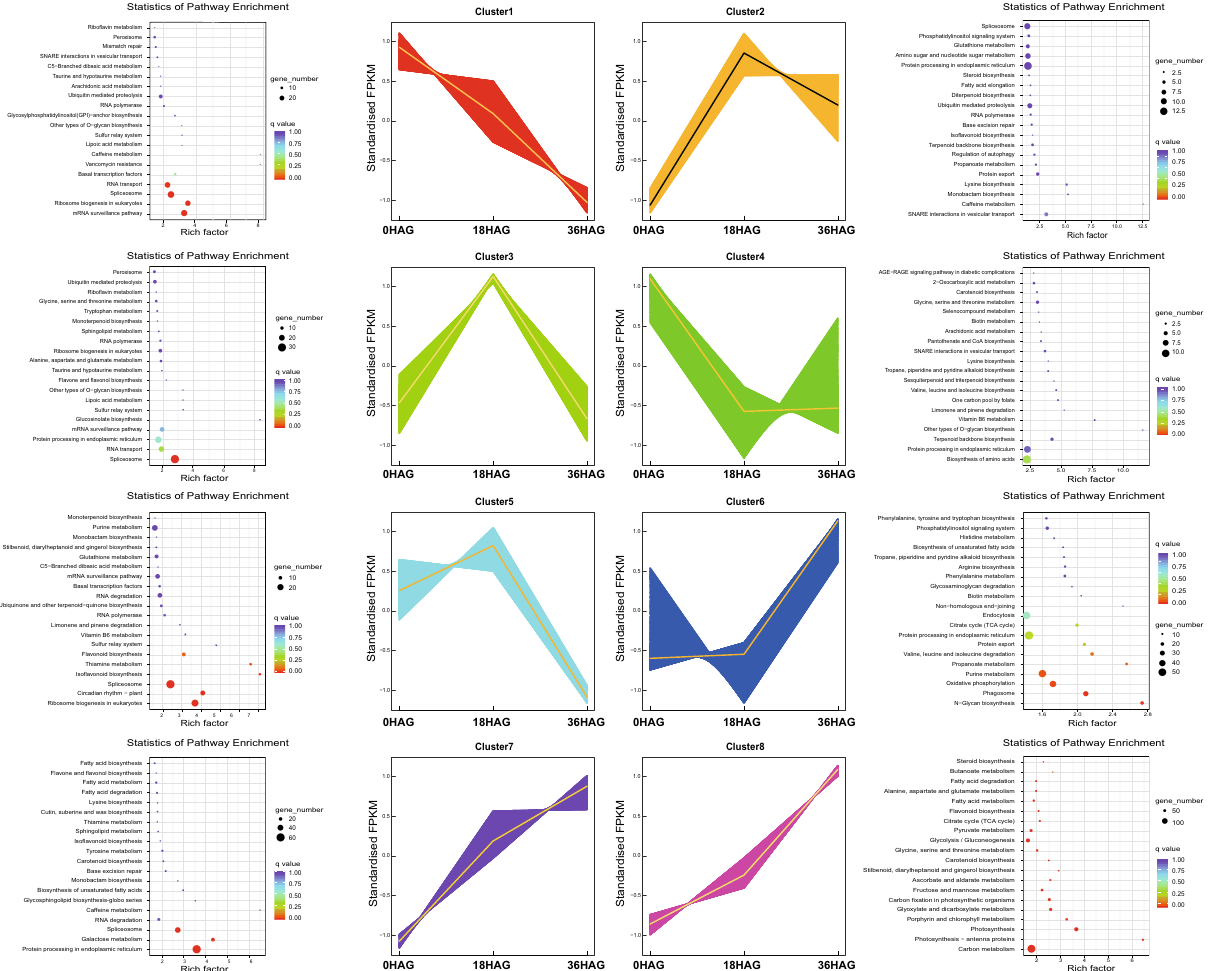
Figure 4. Hierarchy clustering of overall gene expression. Gene expression pattern of all DEGs are classified into 8 clusters, which is displayed by line chart within middle of this figure. KEGG enrichment of DEGs within each cluster are displayed by bubble chart alongside each line